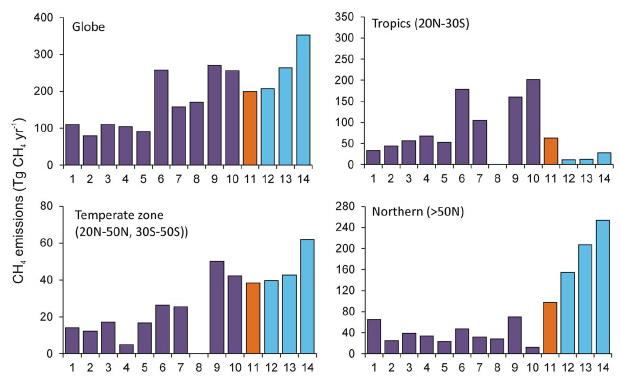
Figure 13. Comparison of total methane emissions (TgCH 4 yr − 1 ) between CLM4.5bgc and other models from natural